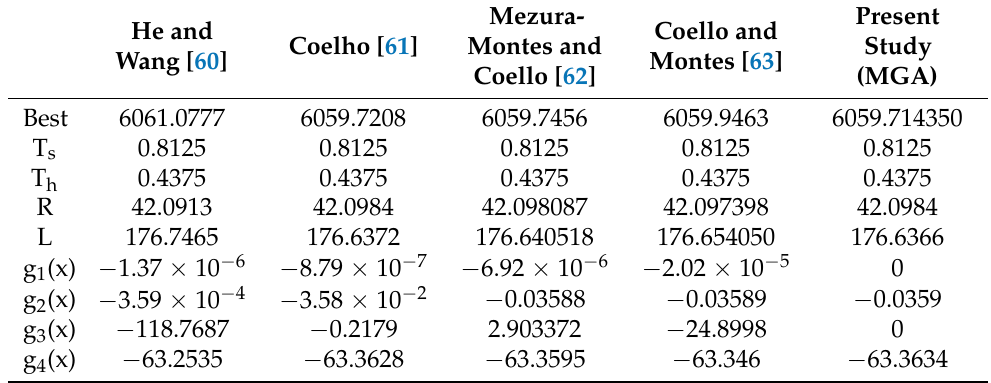
Table A5. Comparison of the best solutions for the pressure vessel design problem.